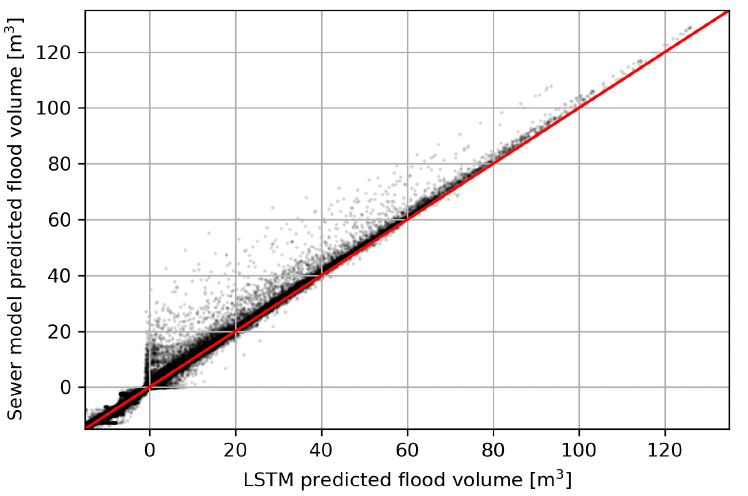
Figure 9. Scatter plot of the predicted and actual flood volumes for the LSTM regressor evaluated on the synthetic validation data set ( R 2 = 0.99). Negative flood volume are plotted until − 15 m 3 , no more false negative or false positive values are observed past this value.